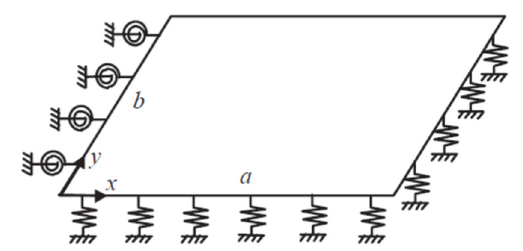
Fig. 1. E lastic restrained edges for a rectangular plate